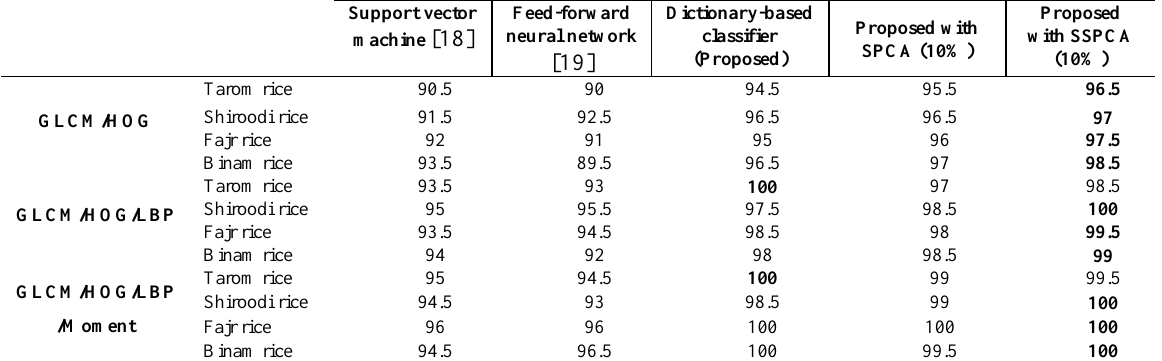
Table 6. Results of the classification rate for rice images based on the combinational feature coefficients for the neural network classifications, support vector machine, and proposed dictionary-based classifier with the SPCA and SSPCA techniques.